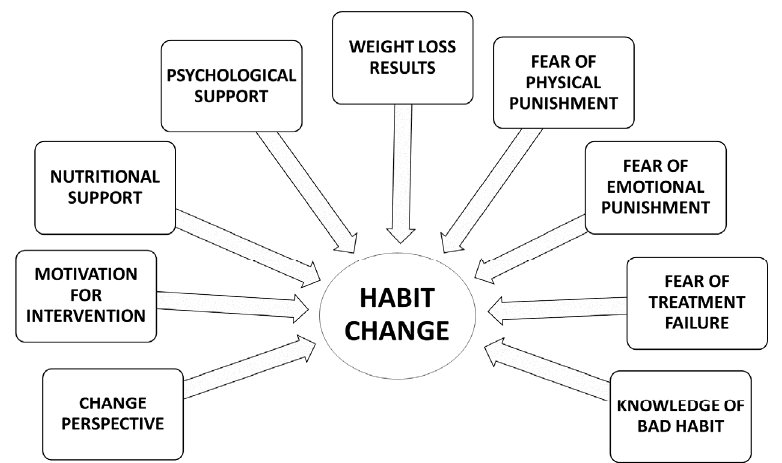
Figure 4. Support factors and motivation for change in bariatric endoscopy.